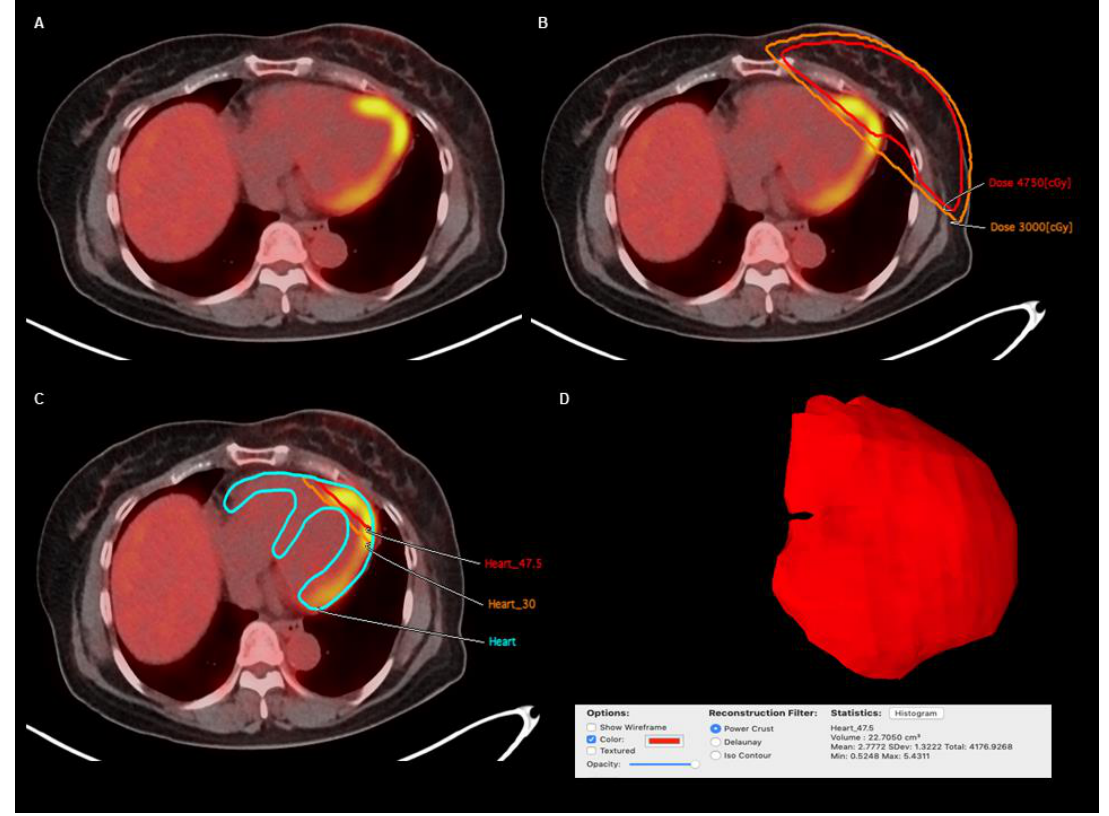
Figure 2. ( A ) Transaxial image and ( B ) transaxial image with dose-distribution on post-radiotherapy F-18 Fluorodeoxyglucose (FDG) positron emission tomography/computed tomography (PET/CT) in a 51-year-old woman with left breast cancer. ( C ) The structures of the whole myocardium (Heart) and myocardium irradiated with 30 Gy (Heart_30) and with 47.5 Gy (Heart_47.5) constructed from CT-stimulation images for radiotherapy were fused with the FDG PET/CT images. For each myocardial structure, the three-dimensional volume structure was automatically constructed and the mean FDG uptake of the volume structure was measured. ( D ) An example of three-dimensional volume structure of myocardium irradiated with 47.5 Gy in this patient is shown, displaying a mean standardized uptake value of 2.7772 for myocardium irradiated with 47.5 Gy.